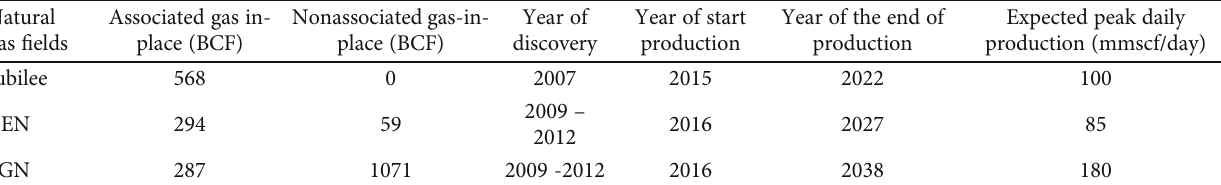
Figure 3: Existing and potential hydropower sites in Ghana [41]. Table 1: Natural gas discoveries and reserves